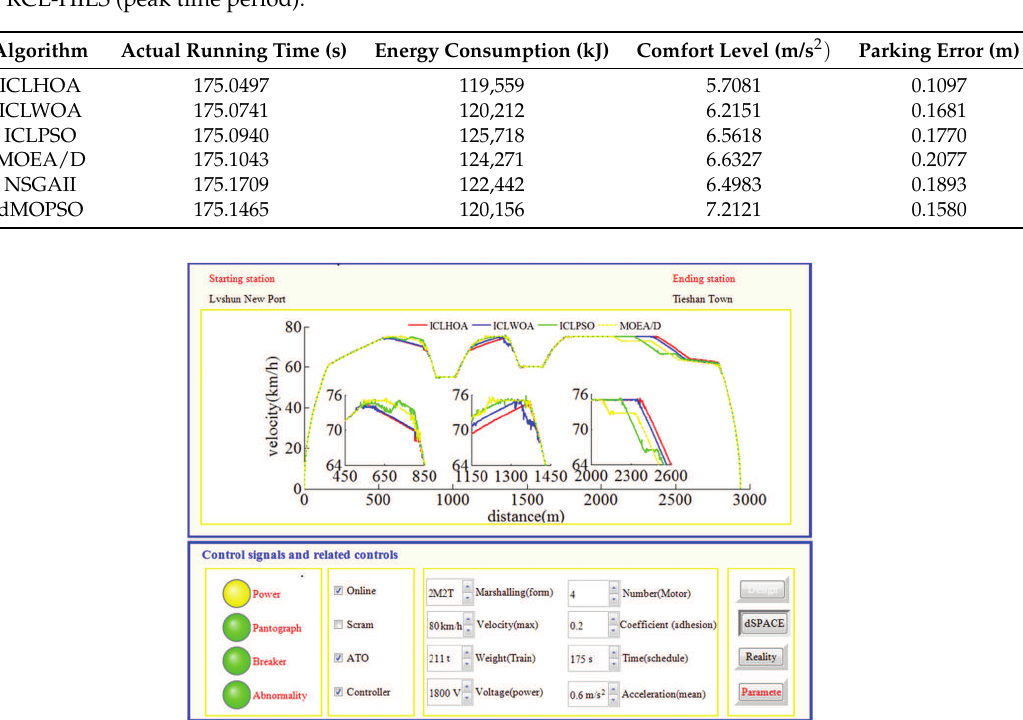
Figure 28. The actual velocity MPC tracking trajectory profile obtained by different algorithms in RCL-HILS (peak time